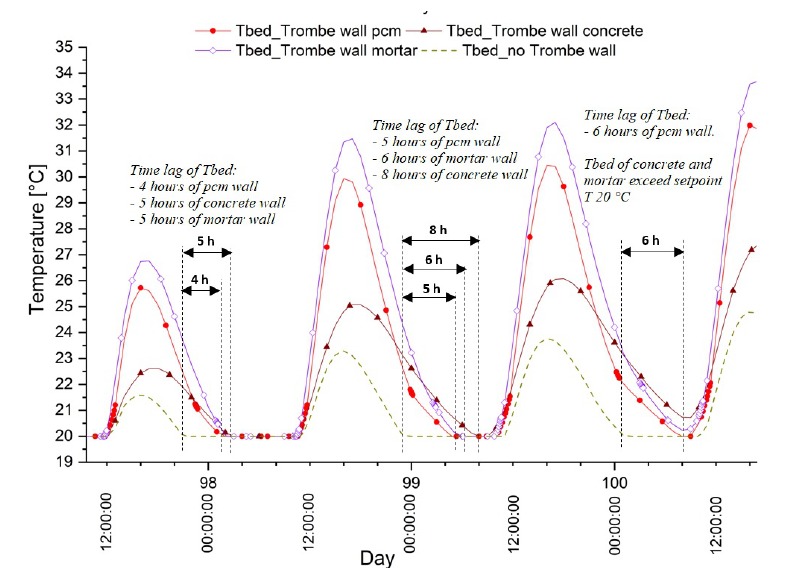
Figure 17. Time lags of various ending temperatures inside the bedroom fitted with the PCM, concrete, and mortar solar Trombe walls vs. the reference case (no solar Trombe wall).